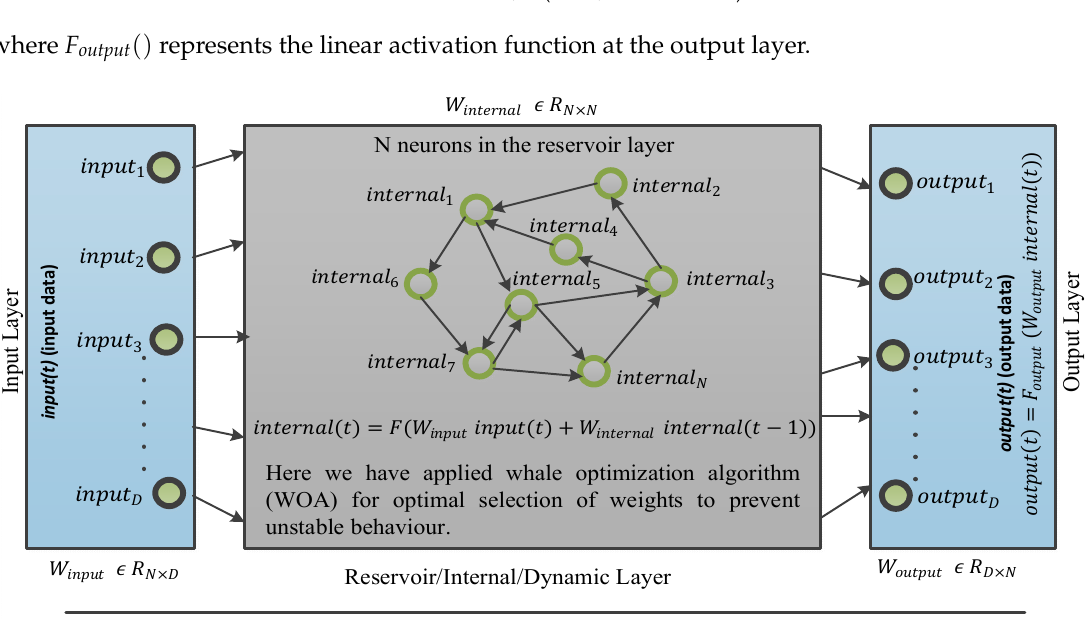
Figure 1. Proposed modified echo state network (MESN).